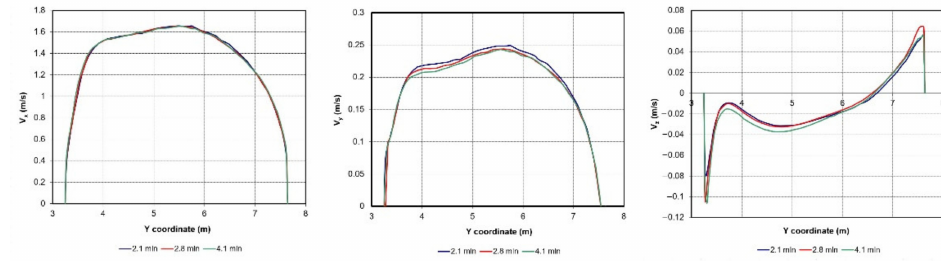
Figure 10. Comparison of velocity vector components for three grid